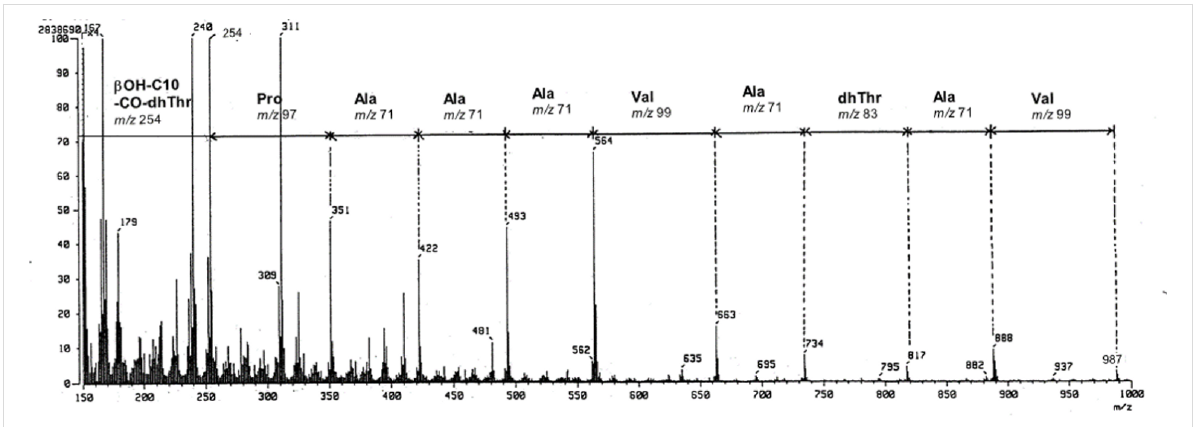
Figure 1: FABMS spectrum (positive mode, NBA matrix) of cichorinotoxin over the mass range of m / z 150 ─ 1000.